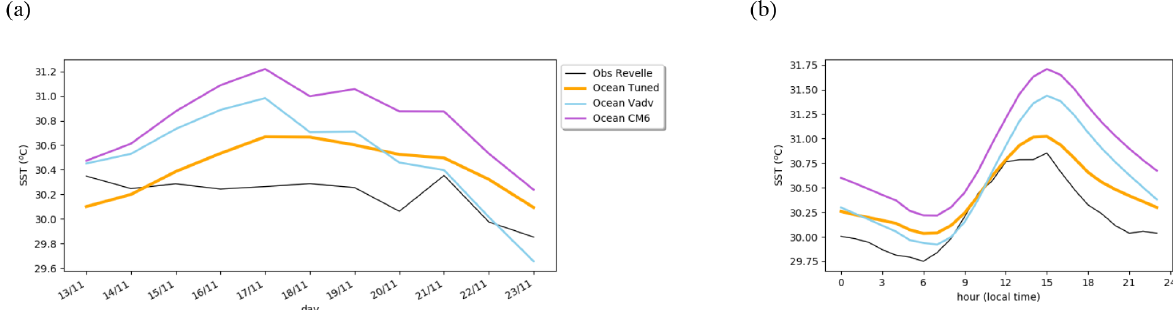
Figure 2. (a) Daily time series and (b) mean diurnal cycle of SST ( ◦ C) in ocean forced experiments compared to SST measured on the R/V Revelle .